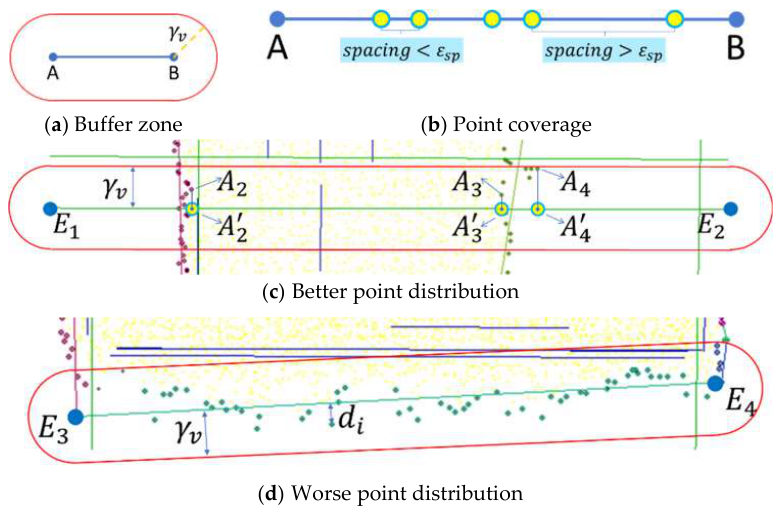
Figure 5. Illustration of the calculation of the point distribution.